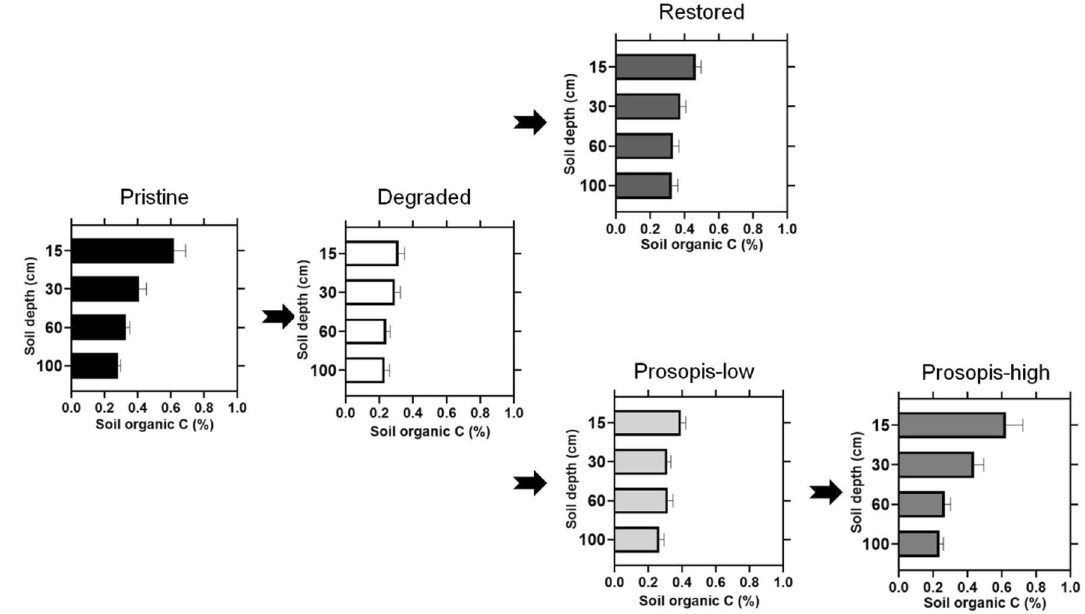
Figure 1. Soil organic carbon concentration (%SOC) for the five land cover types and four soil depth increments. Error bars indicate standard errors. The arrows represent a hypothetical transition from one land cover state to the next over time.